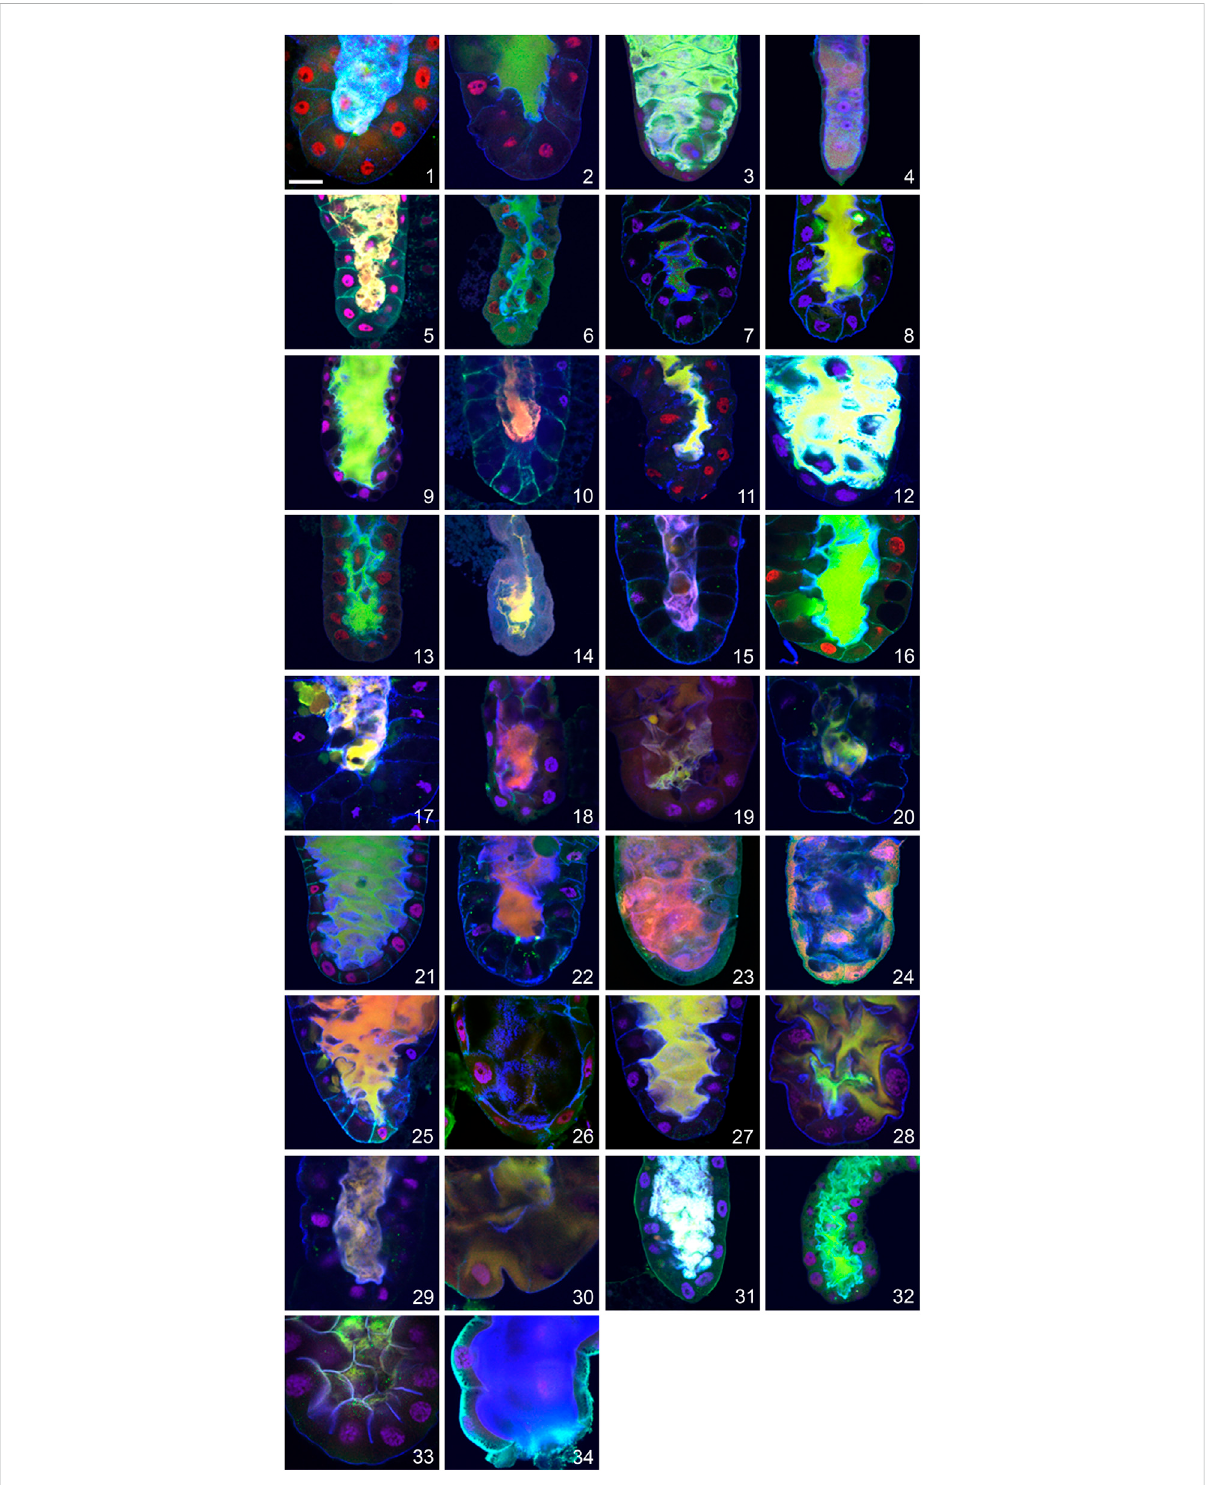
FIGURE 2 EvidenceforapocrinesecretionintheprepupalSGsof32speciesoffamily Drosophilidae andtwounrelateddipteransdocumentedasapositive fl uorescent signal released into centrally located lumen. (1) D. melanogaster , (2) D. simulans , (3) D. montana , (4) C. costata , (5) D. hydei , (6) D. af fi nis , (7) D.bipectinata ,(8) D.willistoni ,(9) D.ananassae ,(10) D.pseudoananassae ,(11) D.yakuba ,(12) D.virilis ,(13) D.atripex ,(14) D.parabipectinata ,(15) D. pallidosa ,(16) D.mauritiana ,(17) D.erecta ,(18) D.lebanonensis ,(19) D.funebris ,(20) D.mojavensis ,(21) D.sechellia ,(22) D.pseudoobscura ,(23) D. persimilis , (24) D. albomicans , (25) D. eugracilis , (26) D. subobscura , (27) D. birchii , (28) D. sulfurigaster , (29) D. equinoxialis , (30) D. immigrans , (31) D. busckii , (32) D. robusta , (33) L. cuprina , and (34) H. illucens . The following proteins were detected in all species: red = transcription factor Broad- Complex, green = cytosolic and cytoskeletal tumour suppressor protein p127 l(2)gl , blue = fi lamentous actin. Nuclear DNA is depicted in violet. In all confocal images the posterior end of the SG oriented down. The scale bar in the lower left corner represents 50